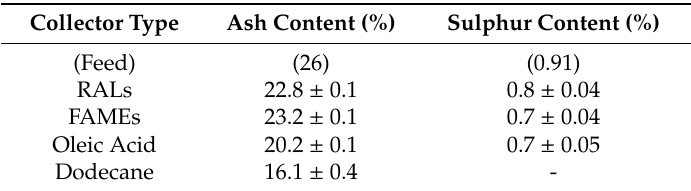
Table 4. Quality of coal recovered from Site 2 tailings using RALs and FAMEs compared to oleic acid and dodecane controls at a fixed dosage of 2.79 kg / t and at pH 2.7.